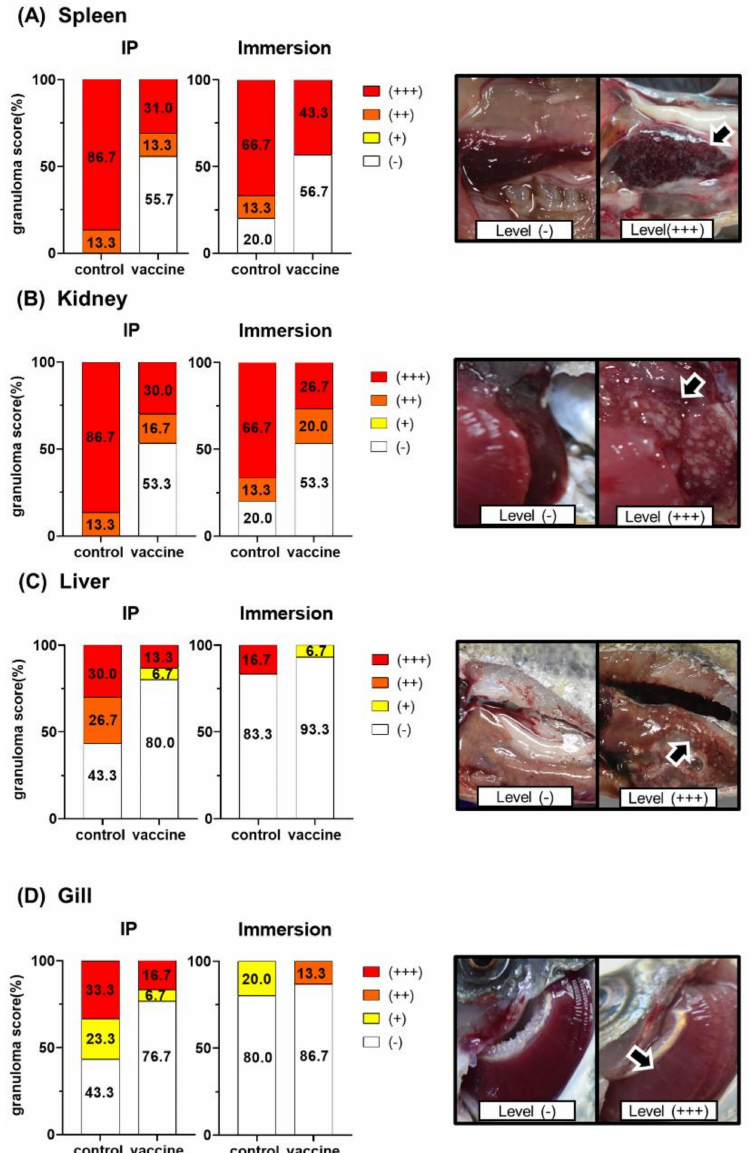
Figure 5. The intensities of granulomas in the spleen ( A ), kidney ( B ), liver ( C ), and gill ( D ) from dead and surviving fish of the control and vaccine groups after the challenge with Fno by the IP and immersion methods. The level of intensity of a granuloma or white nodule was categorized as the following: level (-) no white nodules, ( + ) 1–5 nodules, ( ++ ) 6–10 nodules, and ( +++ ) more than 10 nodules [23]. The intensities of the granuloma scores were calculated as percentages of occurrence among 30 fish per